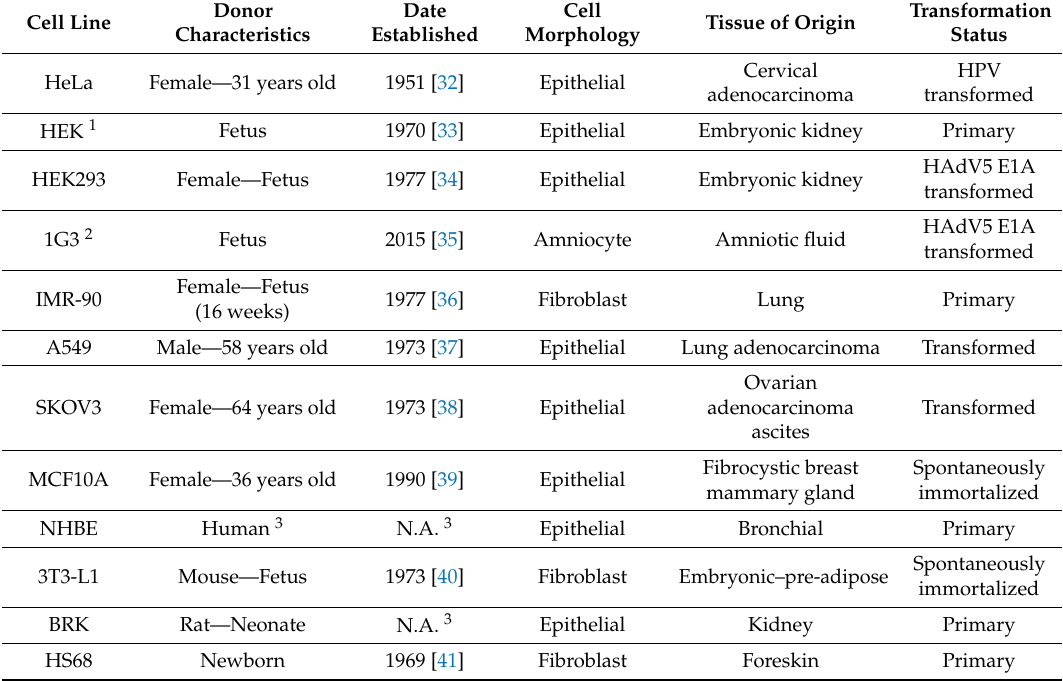
Table 2. Cell lines used by studies outlined in this review. Unless noted otherwise, all cell lines are